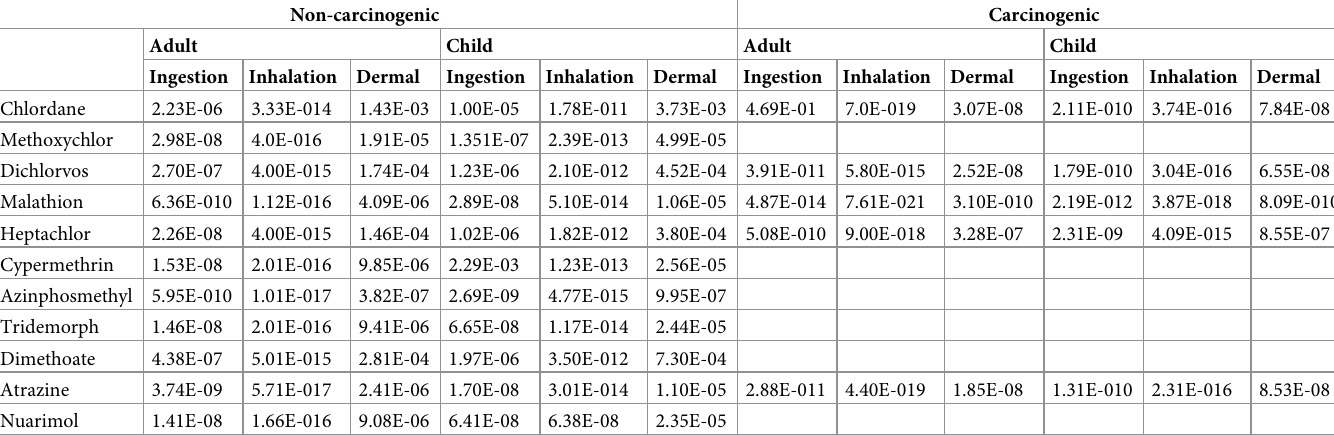
Table 1. Estimation of Chronic daily intake (CDI) and hazard quotient (HQ) for pesticide residues in sediment from middle stretch.